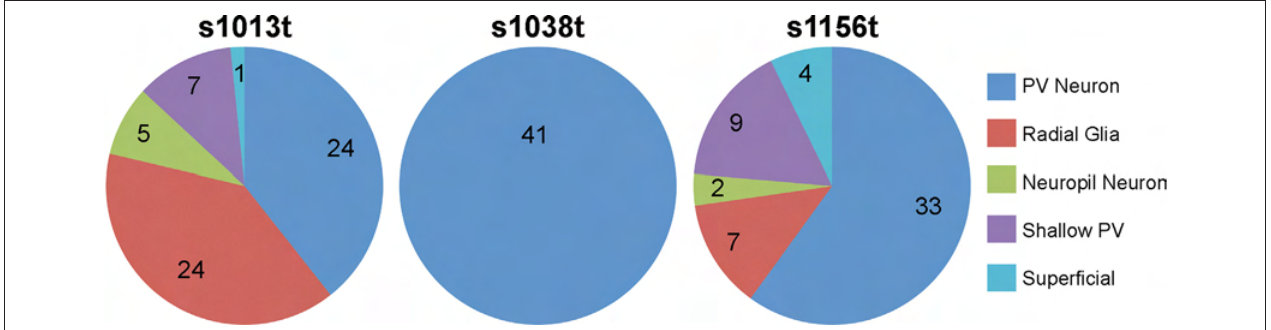
FiGUrE  | Cell types present in each line. For each tectal ET line, the types and frequencies of cells observed are shown. The number of times that each cell type was observed in repeated single cell analyses is indicated for each line and cell